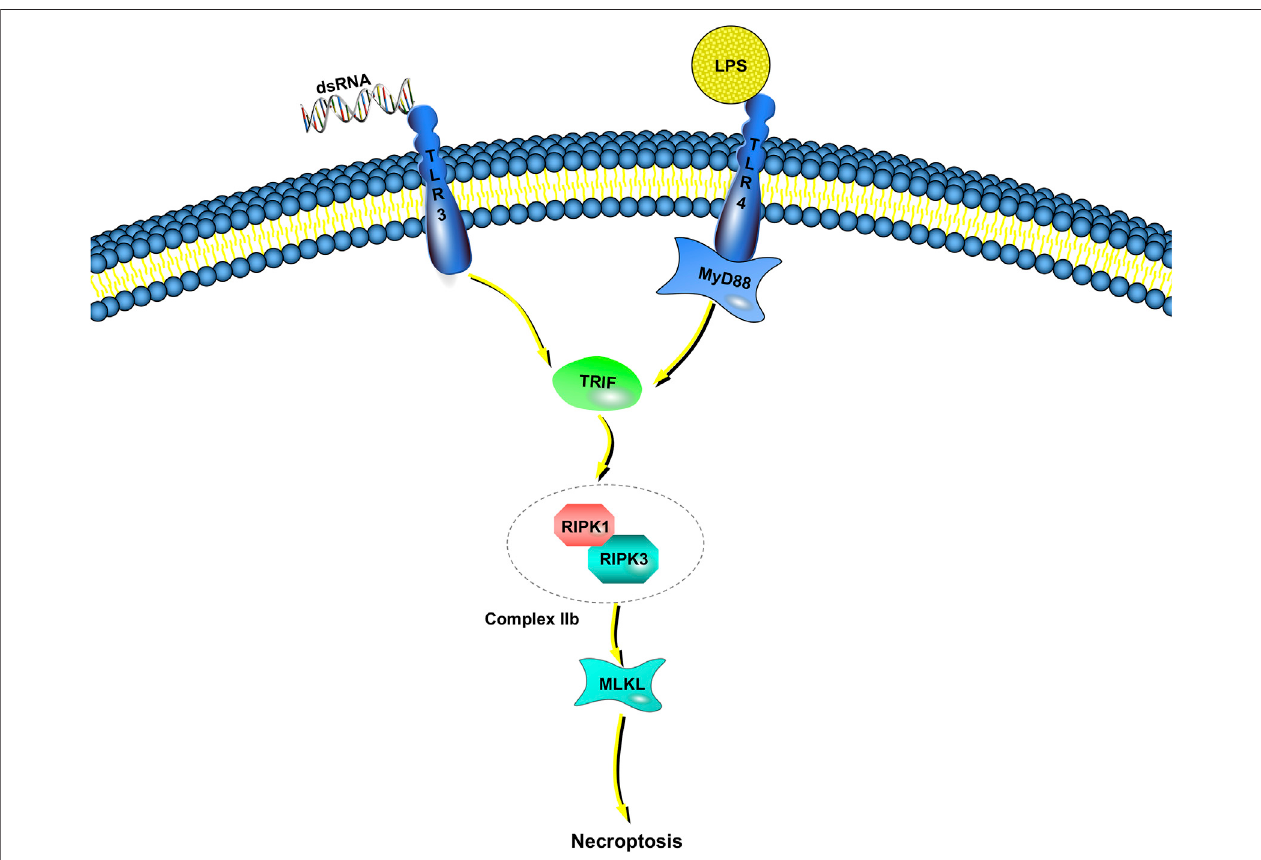
FIGURE 2 | TLR-dependent necroptosis pathways. Engagement ofTLR3/TLR4 with dsDNA or LPS induces the interaction between TRIF and complex IIb, which is combined RIPK1 with RIPK3. If caspase-8 catalytic activity is impaired, complex IIb triggers MLKL-dependent necroptosis. TRIF is the only adaptor protein of TLR3, whereas the TLR4 pathway can be activated by either TRIF or myeloid